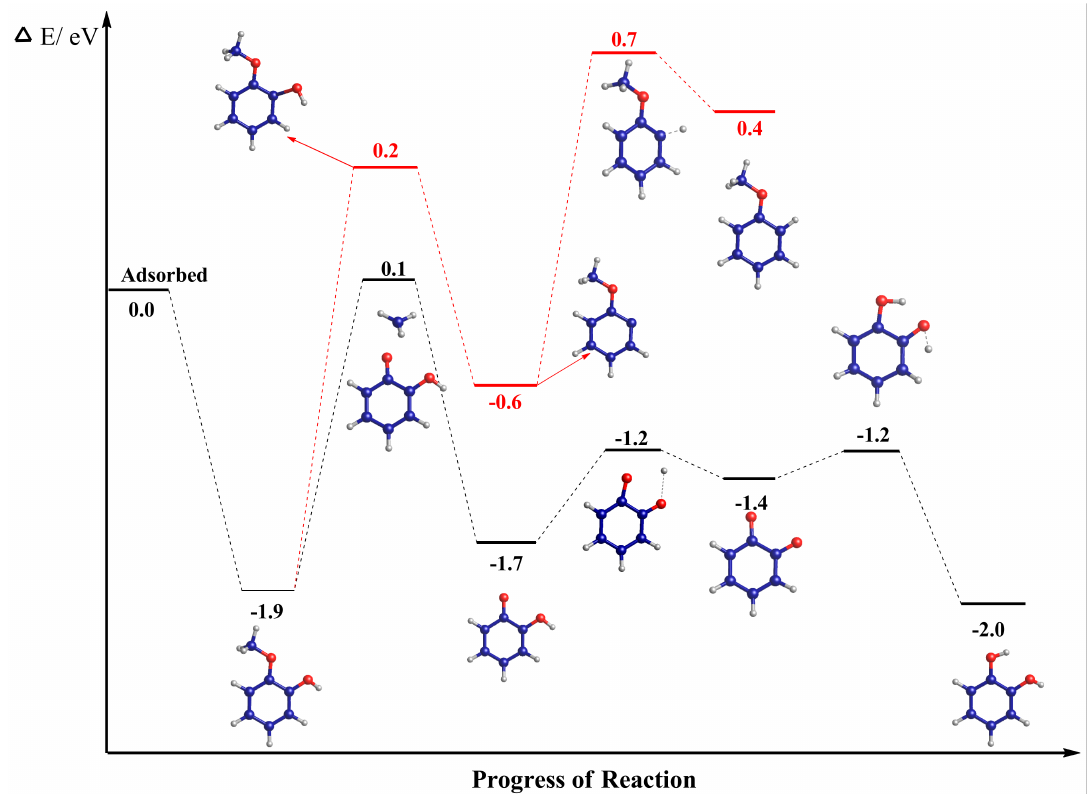
Figure 7. Energy profile diagram for anisole formation, where the activation energies and reaction energies are reported relative to the isolated reactants, i.e., guaiacol, hydrogen gas, and Cu (111) surface. The kinetically accessible pathway is highlighted in red. The broken lines indicate the bonds being formed and broken.